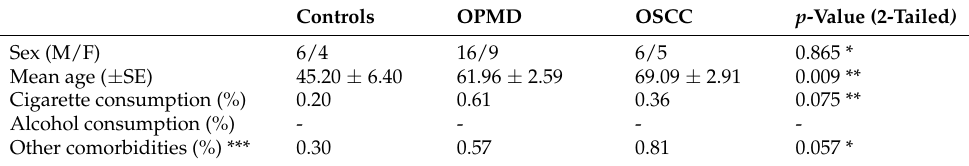
Table 1. Demographic data and comorbidities of patients of the three groups.